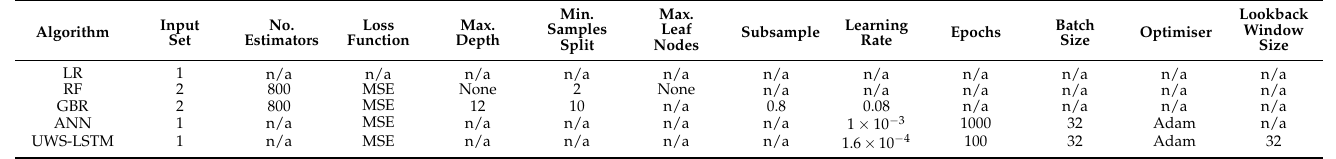
Table 4. Final hyperparameter configuration for each ML